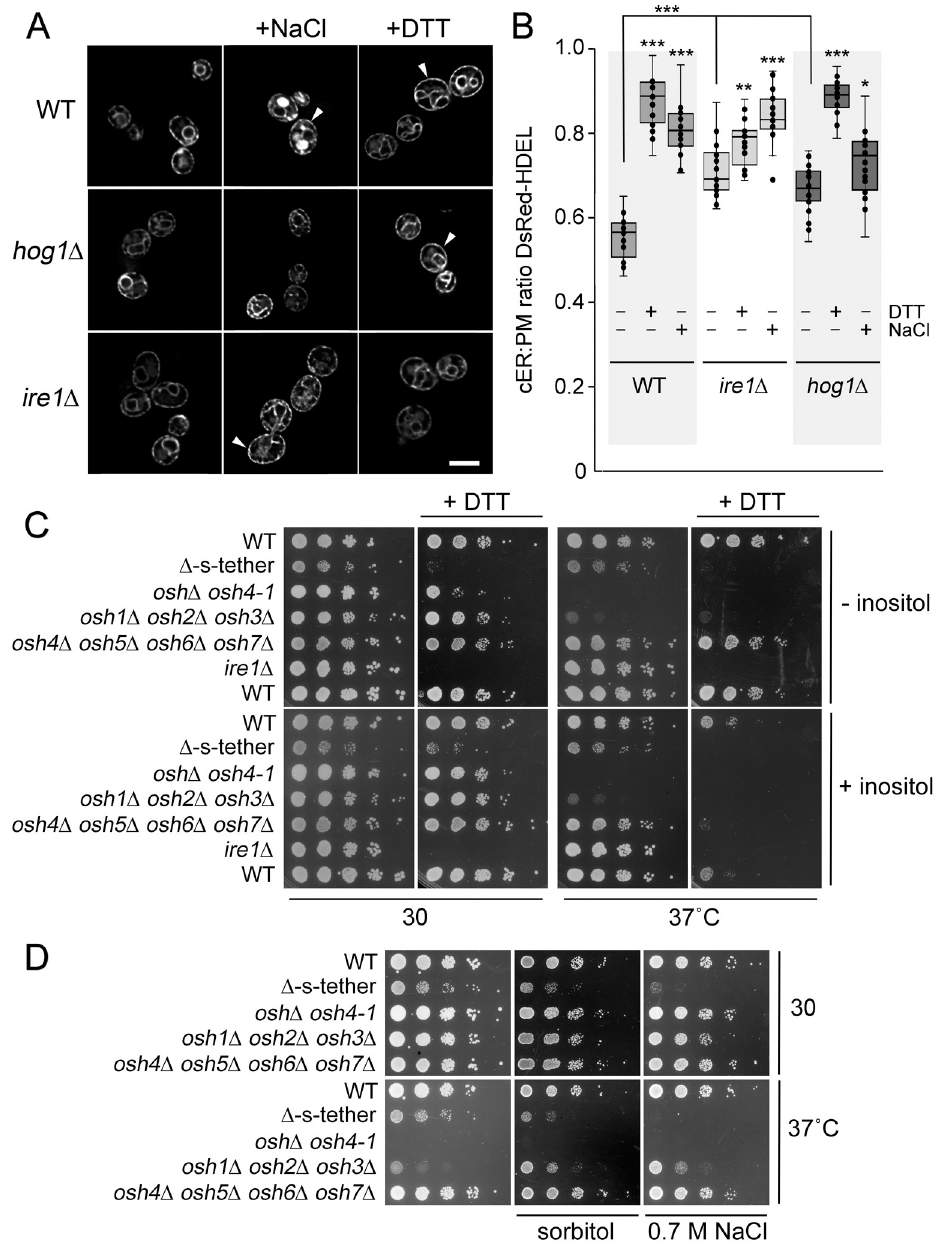
Fig 10. ER-PM MCS dependence on IRE 1, HOG1 , and OSH s. (A) Representative fluorescent microscopy images of WT (BY4741), ire1 Δ (CBY1048), and hog1 Δ (CBY6465) cells expressing DsRed-HDEL (pRS416-DsRed-HDEL). Cells cultured in synthetic complete media were treated with 2 mM DTT or 0.7 M NaCl at 30˚C for 2 h. Arrowheads indicate examples of nearly complete association of ER with the cell cortex. ( B) Ratios of the total length of cortical DsRed-HDEL fluorescence (cER) per total PM length in WT, ire1 Δ , and hog1 Δ cells (n = 20 cells for strain and each condition; statistical significance shown for treated versus untreated cells of the same genotype). ( C) Tenfold serial dilutions of WT (SEY6210), Δ -s-tether (CBY5838), osh4-1 ts osh Δ (CBY926), osh1 Δ osh2 Δ osh3 Δ (JRY6253), osh4 Δ osh5 Δ osh6 Δ osh7 Δ (JRY6272), ire1 Δ (CBY1048) and WT (BY4741) cells spotted onto solid synthetic minimal media with or without 4 mM DTT or 75 μ M inositol and cultured at 30˚C or 37˚C for 2–4 days. ( D) Tenfold serial dilutions of WT, Δ -s-tether, osh4-1 ts osh Δ , osh1 Δ osh2 Δ osh3 Δ , osh4 Δ osh5 Δ osh6 Δ osh7 Δ cells grown on solid synthetic minimal media with or without 0.7 M NaCl or 1M sorbitol at 30˚C or 37˚C for 3–5 days. Box and whisker plots and statistics as described in Fig 1. ��� p � 1.2 x 10 − 7 , �� p = 0.001, � p = 0.01. Scale bars = 5 μ